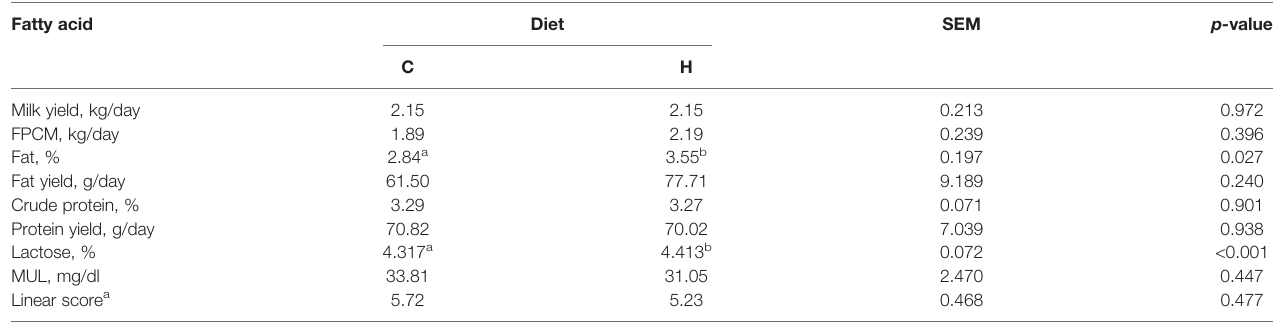
Different letters (a, b) in the same row correspond to statistically different values (p < 0.05).C, control diet; H: hemp seed diet; FPCM, fat and protein corrected milk = milk yield _ (0.26 + 0.1352 _ Fat % + 0.079 _ CP %); MUL, milk urea level. a Linear score: log2 (somatic cell